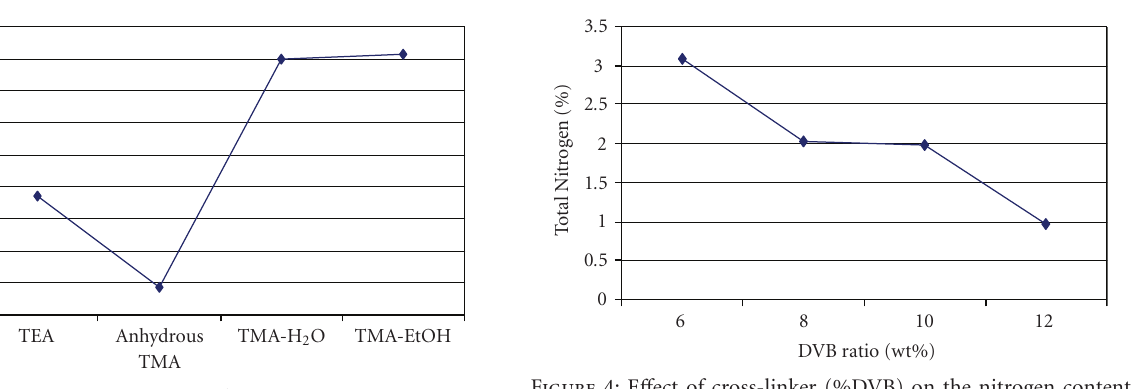
Figure 4: E ff ect of cross-linker (%DVB) on the nitrogen content (after immersing in ethanolic TMA at room temperature for 4